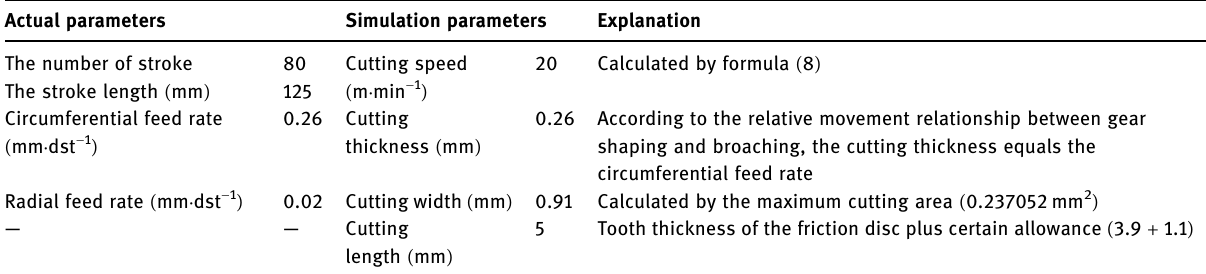
Table 2: Analysis of actual and simulation cutting parameters Actual